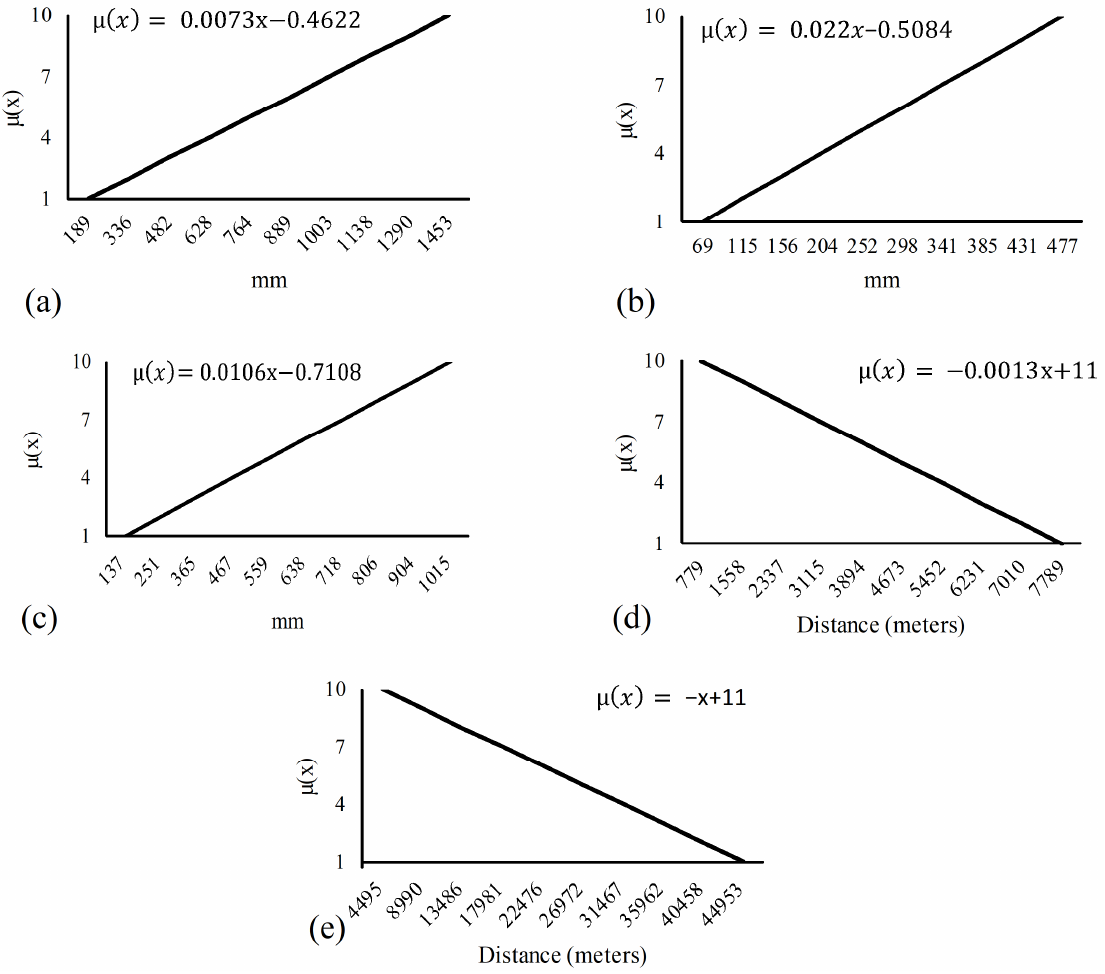
Figure 4. Membership functions adjusted for each studied variable of the flood vulnerability model.